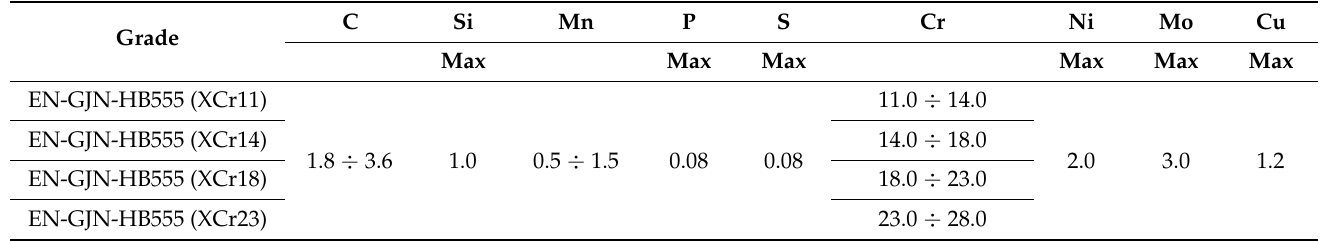
Table 1. Chemical composition and hardness of high-chromium cast iron resistant to abrasive